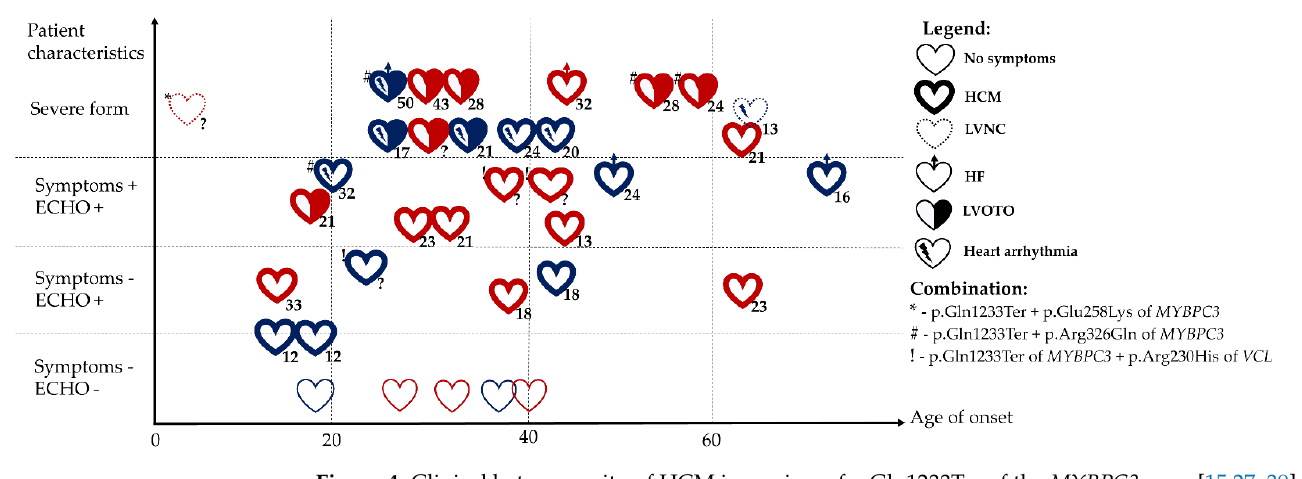
Figure 4. Clinical heterogeneity of HCM in carriers of p.Gln1233Ter of the MYBPC3 gene [15,27–39]. Legend. ECHO: echocardiographic signs of myocardium hypertrophy, HCM: hypertrophic cardiomyopathy, LVNC: left ventricular non-compaction, HF: heart failure, LVOTO: left ventricular outflow tract obstruction, ?: no data on left ventricular thickness. Red heart: female; blue heart: male. The numbers outside each heart indicate maximum thickness of the left ventricle (mm).